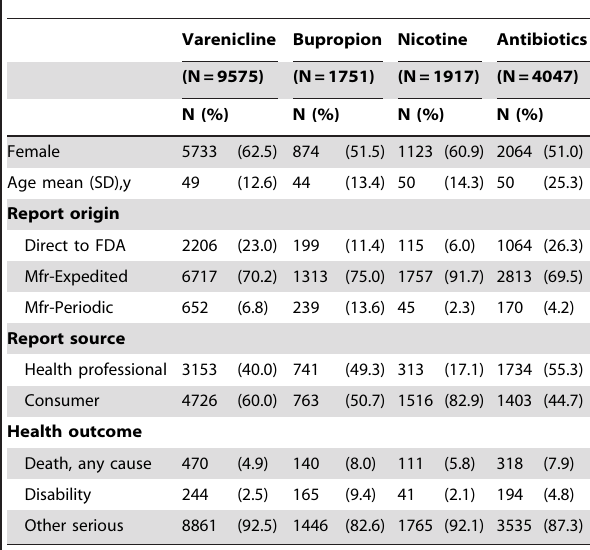
Table 1. Characteristics of Adverse Drug Event